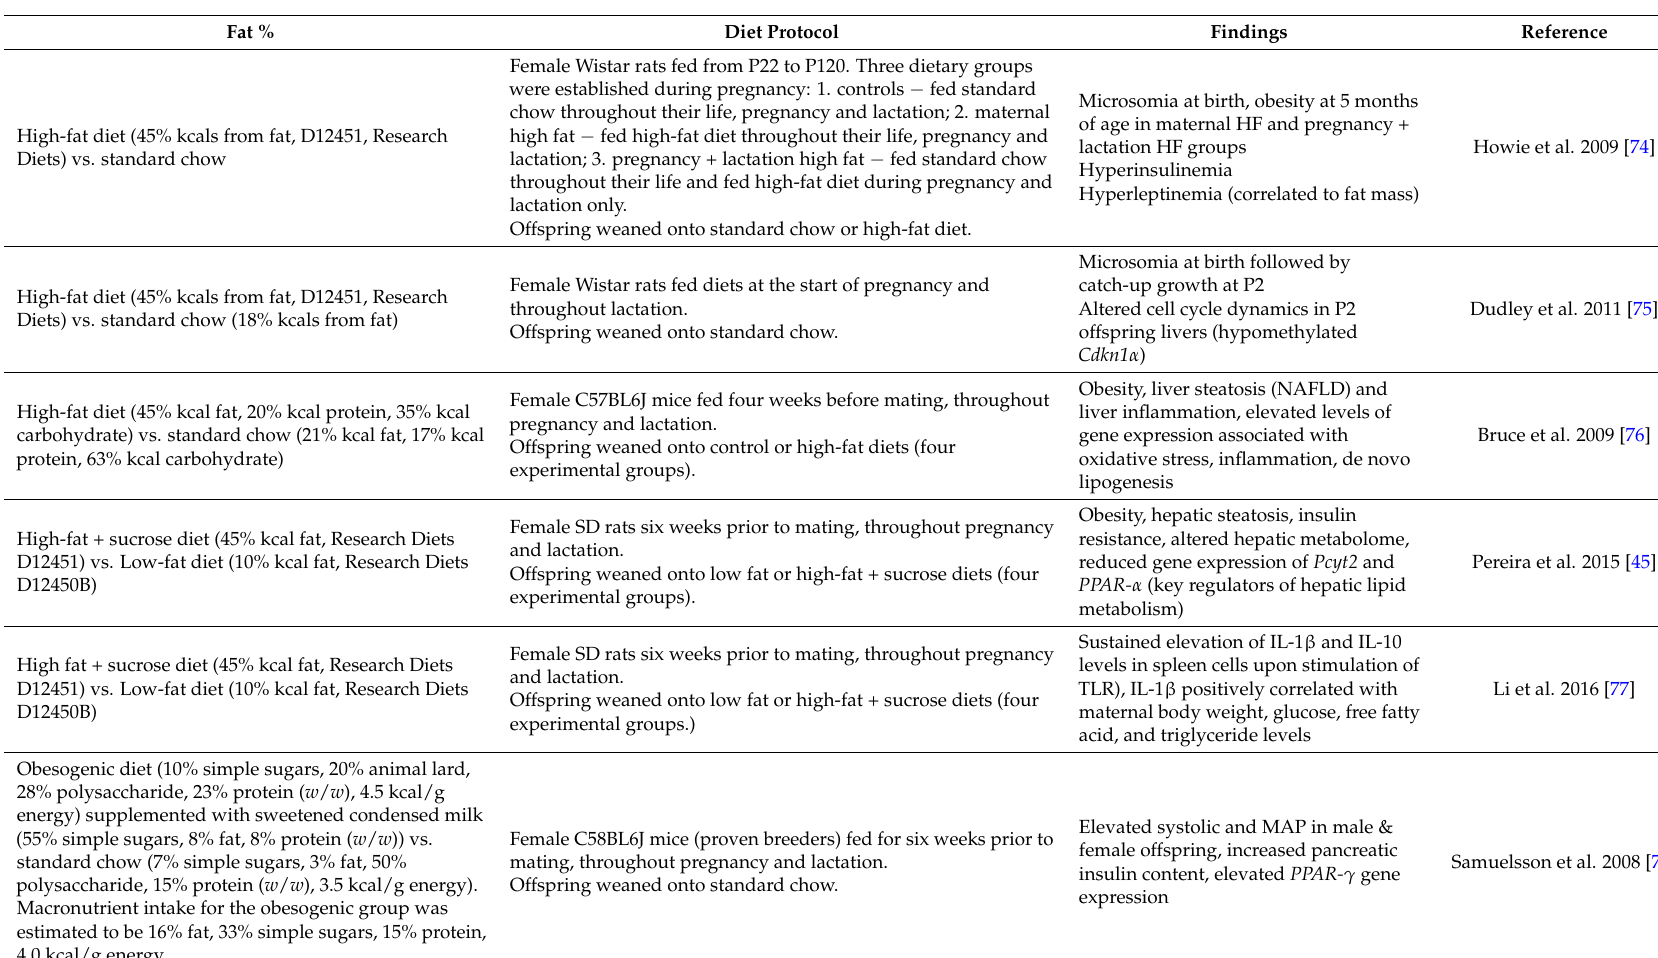
Table 4. Summary of evidence for long-term influences of maternal high fat and sucrose on offspring health outcomes. Fat % Diet Protocol Findings Reference Female Wistar rats fed from P22 to P120. Three dietary groups were established during pregnancy: 1. controls − fed standard chow throughout their life, pregnancy and lactation; 2. maternal high fat − fed high-fat diet throughout their life, pregnancy and lactation; 3. pregnancy + lactation high fat − fed standard chow throughout their life and fed high-fat diet during pregnancy